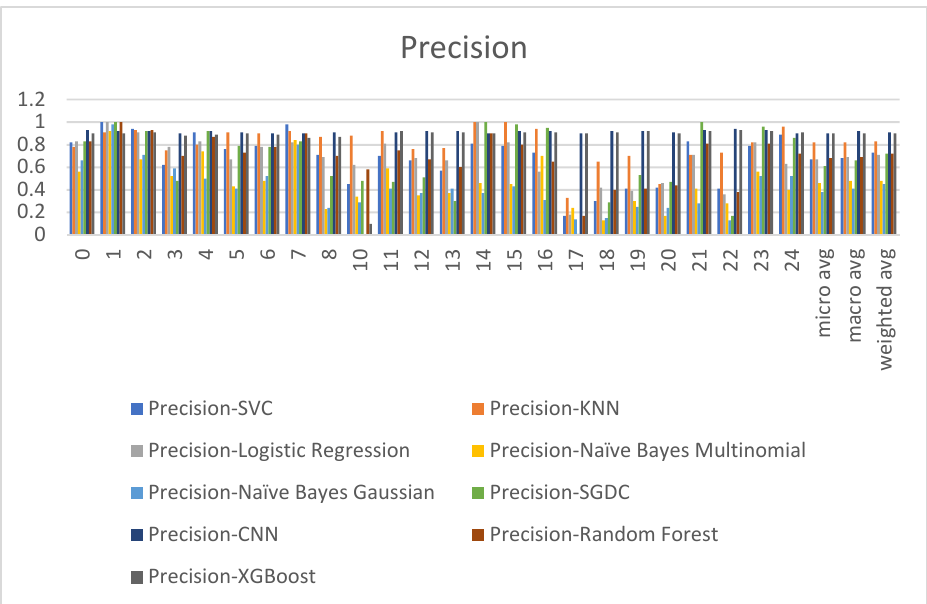
Figure 3. Selected machine learning algorithms vs. accuracy.